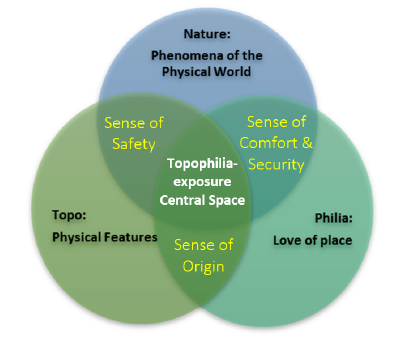
Figure 1. Topophilia-Exposure Central Space Concept Model The intersections is mathematically expressed as the sets of {Topophilia-Exposure} ~ {Sense of Safety} ∩ {Sense of Comfort} ∩ {Sense of